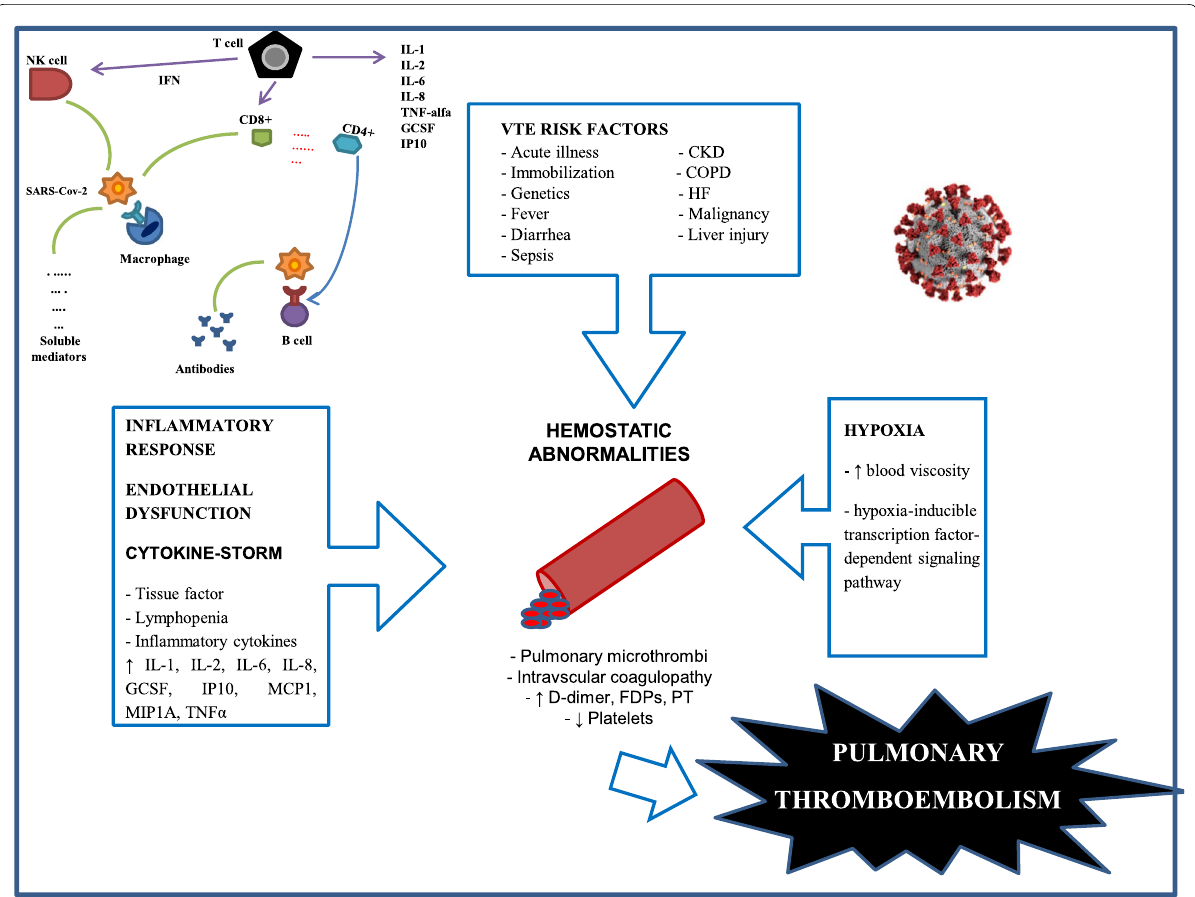
Fig. 1 Schematic representation of the possible pathophysiologic mechanisms underlying pulmonary embolism (PE) in patients with coronavirus disease-2019 (COVID-19). CD: CD receptor, CKD: chronic renal failure, COPD: chronic obstructive pulmonary disease, FDP: fibrin degradation products, GCSF: granulocyte-colony stimulating factor, HF: heart failure IFN: interferon, IL: interleukin, IP: interferon-gamma induced protein, MCP: monocyte chemotactic protein, MIP: macrophage inflammatory protein, NK: natural killer cells, PT: prothrombin time, SARS CoV-2: acute respiratory syndrome coronavirus 2, TNF alpha: tumor necrosis factor